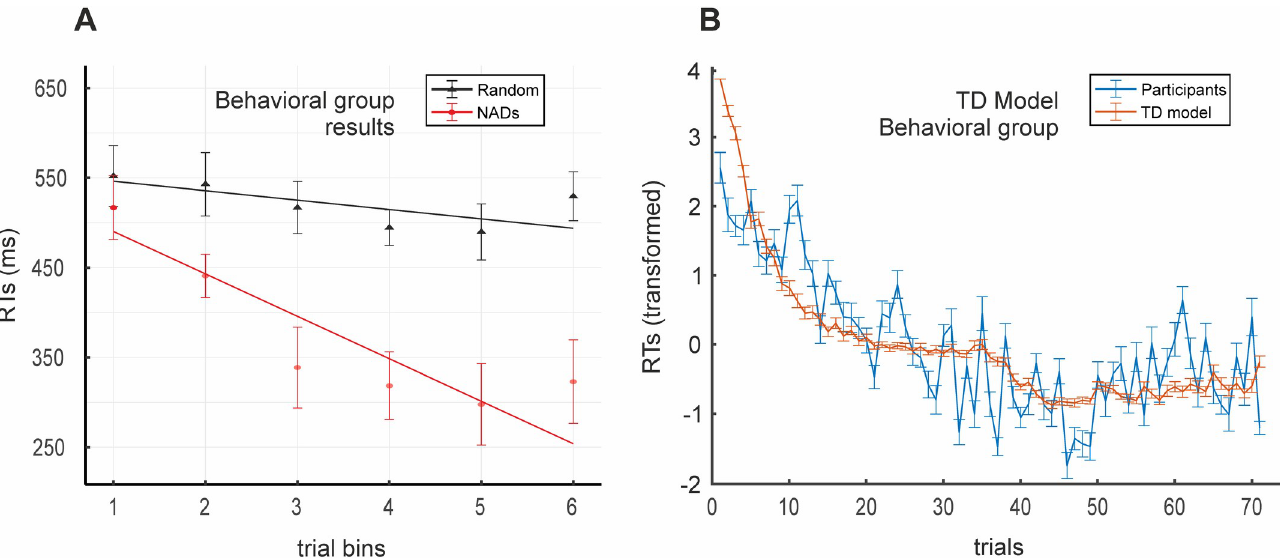
Fig 2. Behavioral group’s SL and TD model results. (A) Slopes for NADs and Random blocks ( N = 19) derived from the linear mixed model. A significantly steeper slope for the NADs block (red) compared to the Random block (black) indicates SL over trials. Actual data shown averaged into 6 trial bins with the SEM for display purposes only. All data points per participant were used for the linear mixed model analysis. (B) Plot of participants’ mean RTs (blue) against the TD model’s estimates of the development of predictions over learning (red; inverted as 1- P (A) before averaging and z-scoring for display purposes). Vertical bars = SD. RTs were initially transformed (see Materials and methods) and are plotted with the inverted model estimates in z-score values. P (A) = TD model’s predictions from the initial word (A) of the dependencies. Data used to generate Fig 2 can be found in S1 Data. NAD, nonadjacent dependency; RT, reaction time; SL, statistical learning; TD, temporal